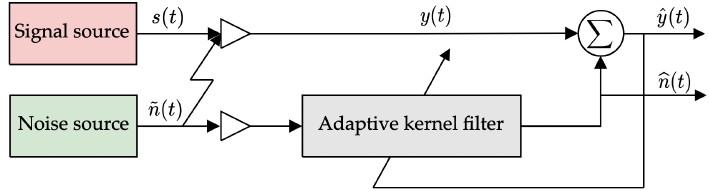
Figure 2. Schematic diagram of the adaptive noise-reduction structure of the